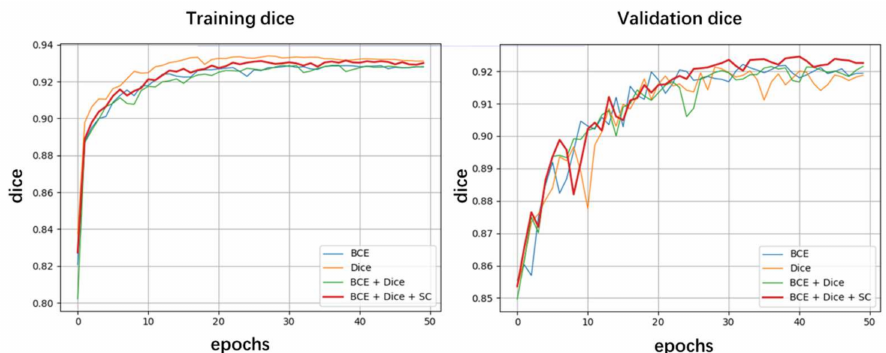
Figure 7. Dice rate on the training (left) and validation datasets (right) of different loss